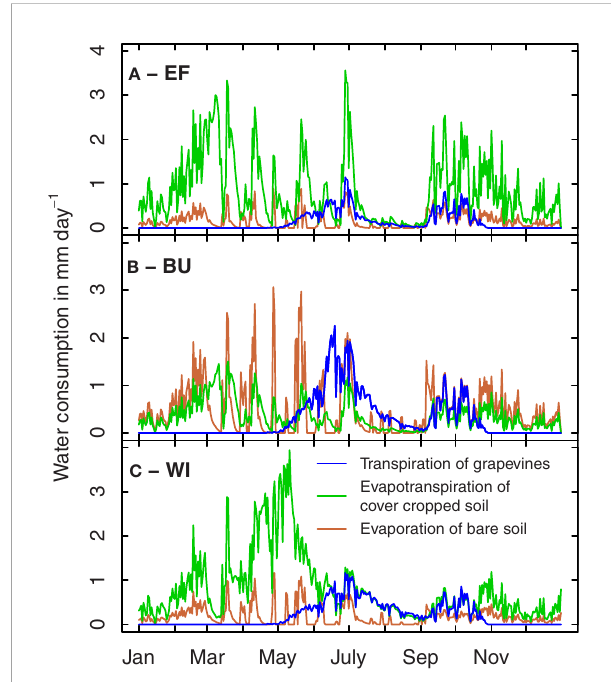
FIGURE 1 Example simulation of grapevine transpiration, evapotranspiration of cover cropped soil and evaporation of bare soil for three vineyards in the Rheingau region in 2022 (A – C) . (A) Ehrenfels vineyard, row spacing 2.50 m, 85 mm available water capacity (AWC), fully cover cropped with exception of the undervine area (width 0.4 m). (B) Burgweg vineyard, row spacing 1.60 m, 115 mm AWC, every other row cover cropped. (C) Wilgert vineyard, row spacing 1.60 m, 320 mm AWC, fully cover cropped with exception of the undervine area. Development of cover crops is divided into several growth